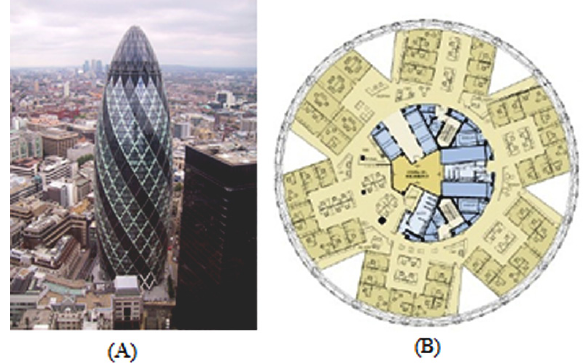
Fig. 2. (A) Exterior façade of Swiss Re Tower; (B) The plan of Swiss Re Tower (Foster 2015) Rating of Swiss Re Tower has been calculated as follows.